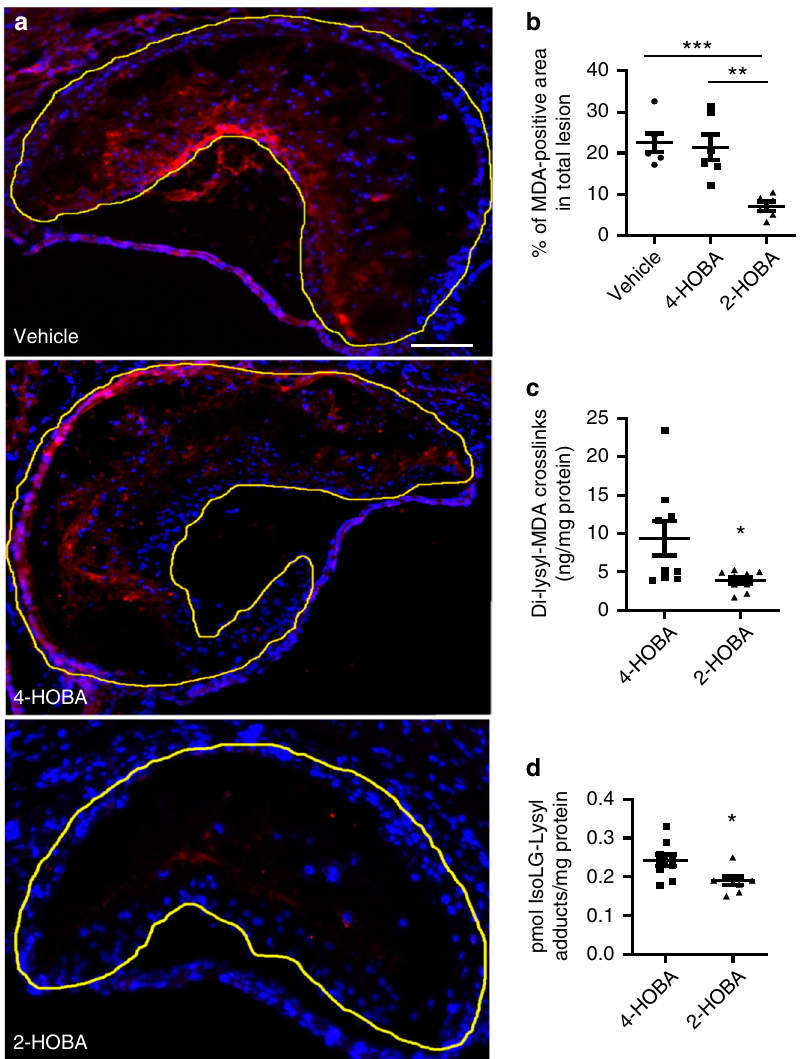
Fig. 2 2-HOBA decreases the MDA adduct content of proximal aortic atherosclerotic lesions in Ldlr − / − mice. a, b MDA was detected by immuno fl uorescence using anti-MDA primary antibody and fl uorescent-labeled secondary antibody (red). Nuclei were counterstained with Hoechst (blue). Representative images ( a ) and quantitation ( b ) of MDA staining in proximal aortic root sections. Scale Bar = 50 µ m. n = 6 biologically independent mice per group. Data are expressed as mean ± SEM. One-way ANOVA with Bonferroni ’ s post hoc test, p values of 2-HOBA vs 4-HOBA and 2-HOBA vs vehicle are **0.0017 and ***0.0008, respectively. c Aortic tissues were isolated from the Ldlr − / − mice and Dilysyl-MDA crosslinks were measured by LC/MS/ MS. n = 9 biologically independent mice per group. Data are presented as mean ± SEM. Two-sided unpaired t test, p value of 2-HOBA vs 4-HOBA is *0.0262. d Aortic tissues were isolated from the Ldlr − / − mice and IsoLG-Lysyl was measured by LC/MS/MS. n = 9 (4-HOBA) or 8 (2-HOBA) biologically independent mice. Data are presented as mean ± SEM. Two-sided unpaired t test, p value of 2-HOBA vs 4-HOBA is *0.0151. Source data are provided as a source data fi